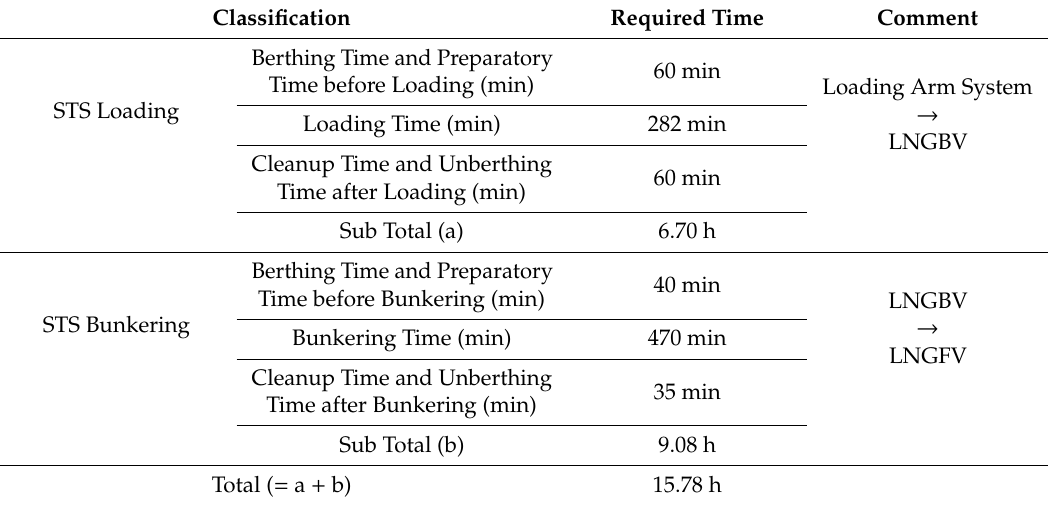
Table 12. LNG Charging Time and Bunking Time by STS Type in Busan Port.